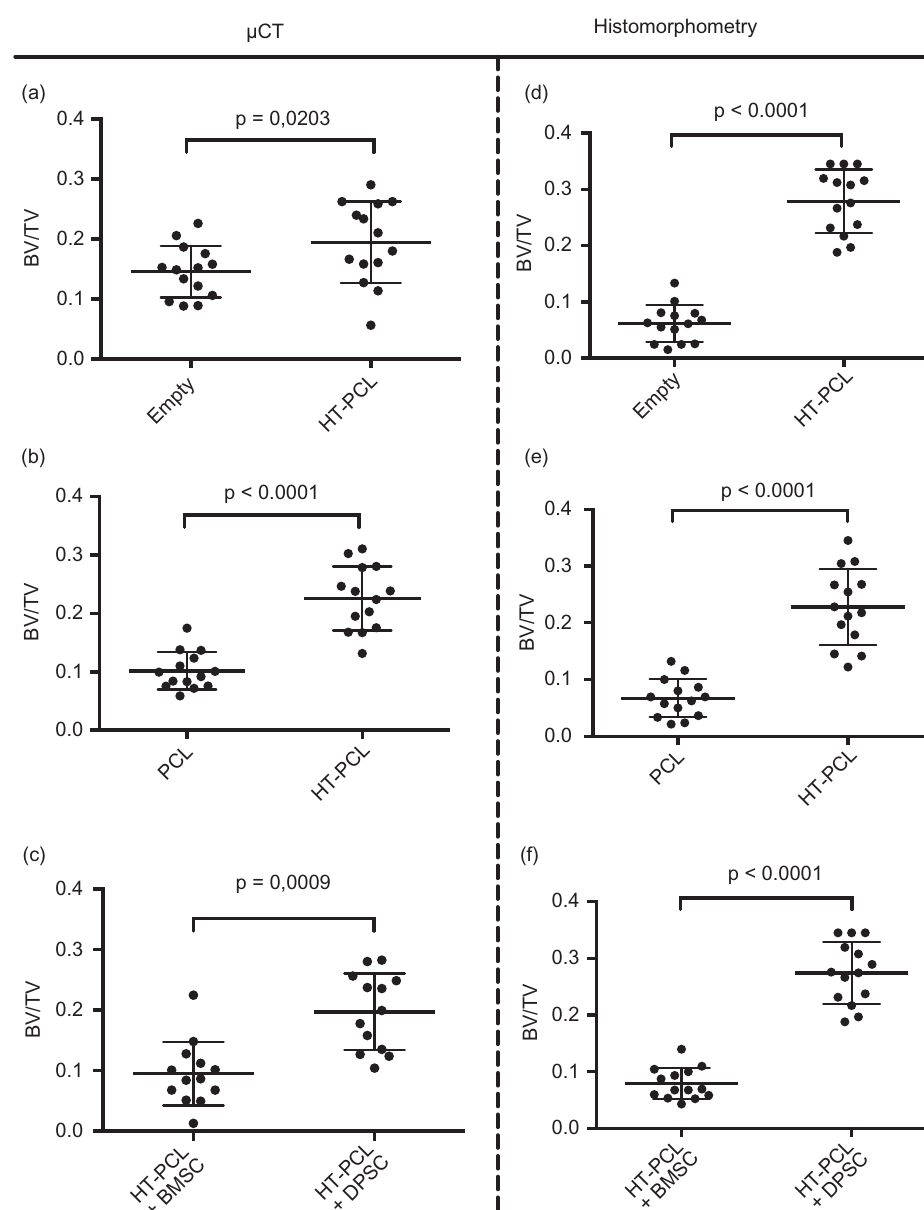
Figure 4. In vivo BV/TV results estimated with l CTand histomorphometry are presented as scatter plots. Individual data points are depicted with dots and middle bar represents the mean. Top and bottom bar represents standard deviations. The top two scatter plots (a and d) represent the paired sub-study with an empty defect and a HT-PCL scaffold. Middle two scatter plots (b and e) illustrate the PCL vs. HT-PCL sub-study, whereas bottom scatter plots (c and f) represent autologous BMSCs on HT-PCL scaffolds vs. autologous DPSCs on HT-PCL